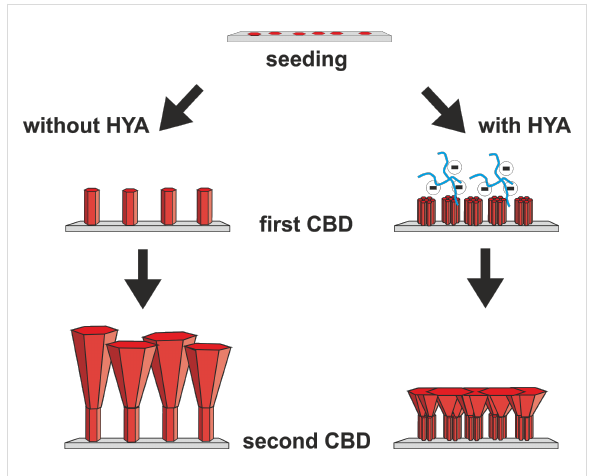
Figure 7: Scheme of the proposed mechanism for the three-step ZnO film deposition process described in this